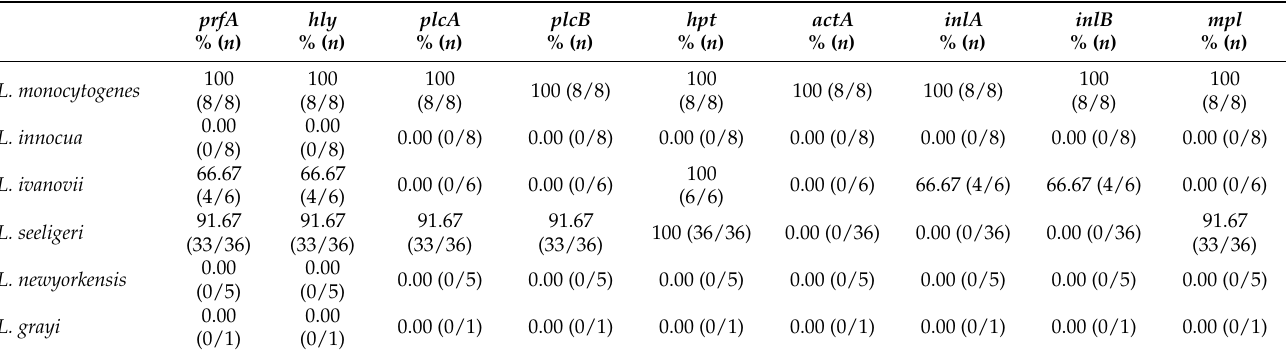
Table 4. Prevalence of virulence genes in 64 Listeria